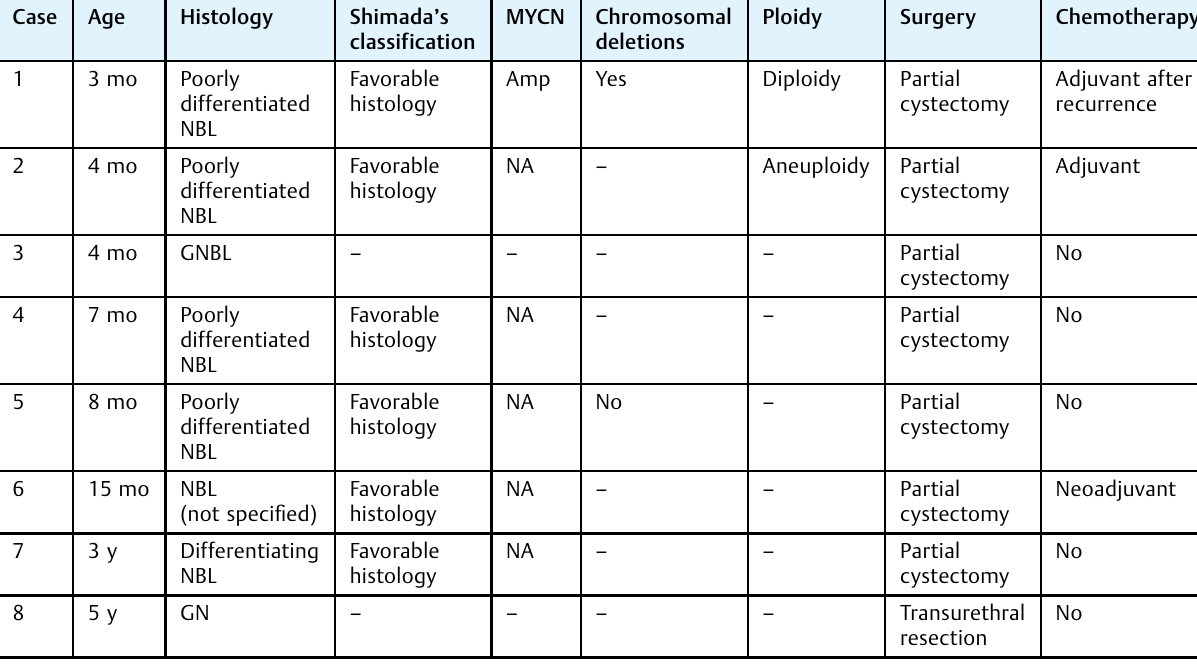
Table 1 Characteristics of eight reported cases of neuroblastoma of the urinary bladder